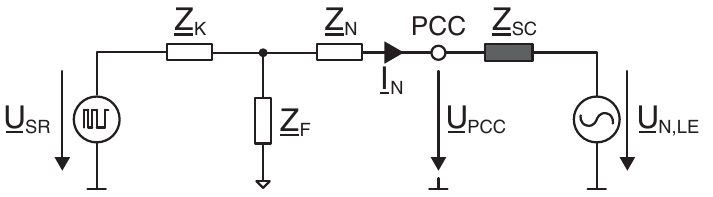
Figure 10. Single leg diagram of the LCL-Filter with most important impedances for the calculation of the U PCC